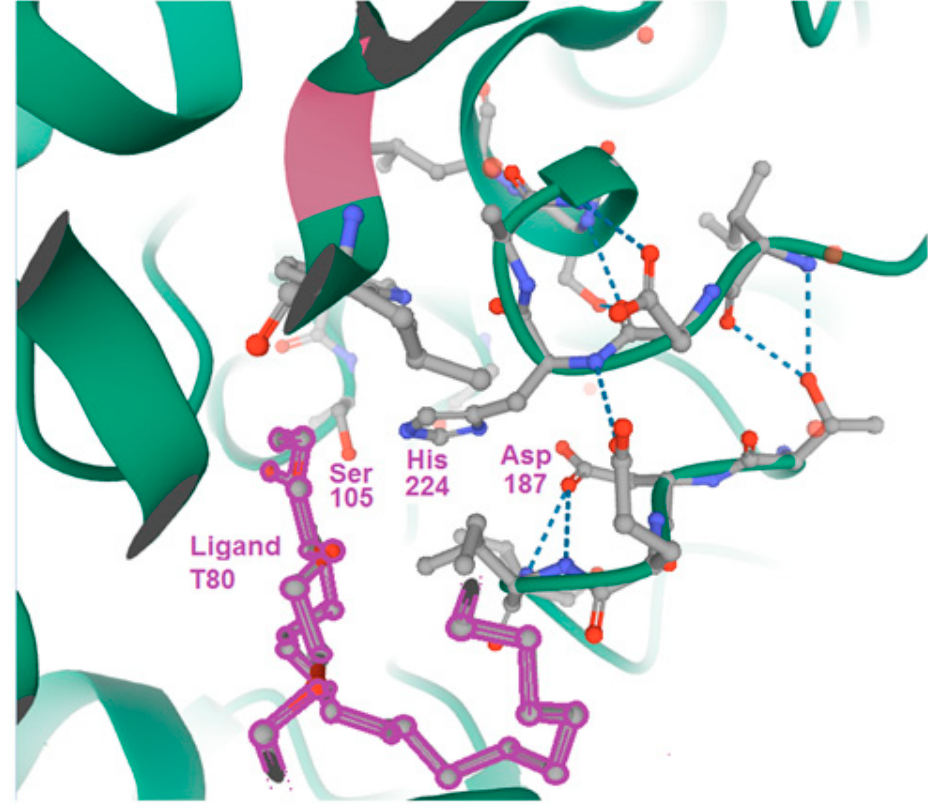
Figure 3. Nonspecifically bound ligand T80, present in the active center of CAL-B in PDB structure 1LBT [29]. The Figure was created using RCSB PDB Jmol software [36,37].